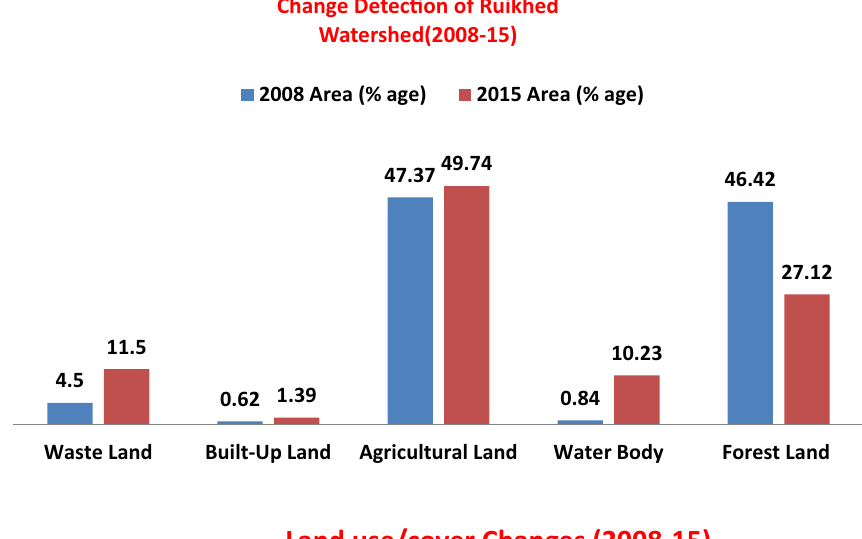
Fig. 7 Graph showing change